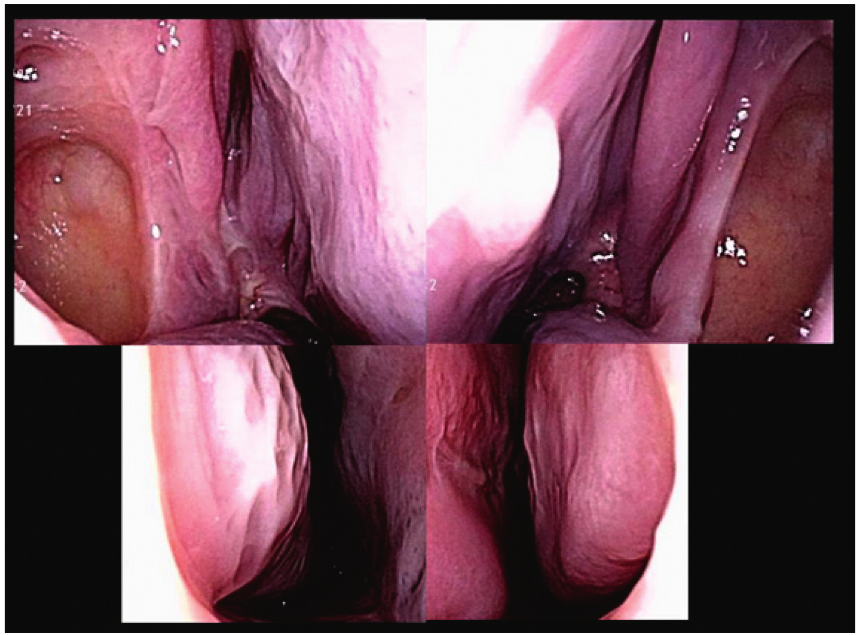
Figure 4: Postoperative endoscopic findings. The endoscopic findings showed a normal appearance.